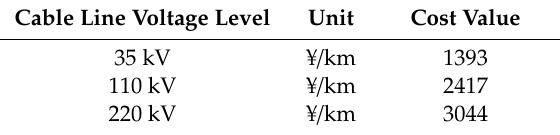
Table 3. Cable Line of the RMRC.